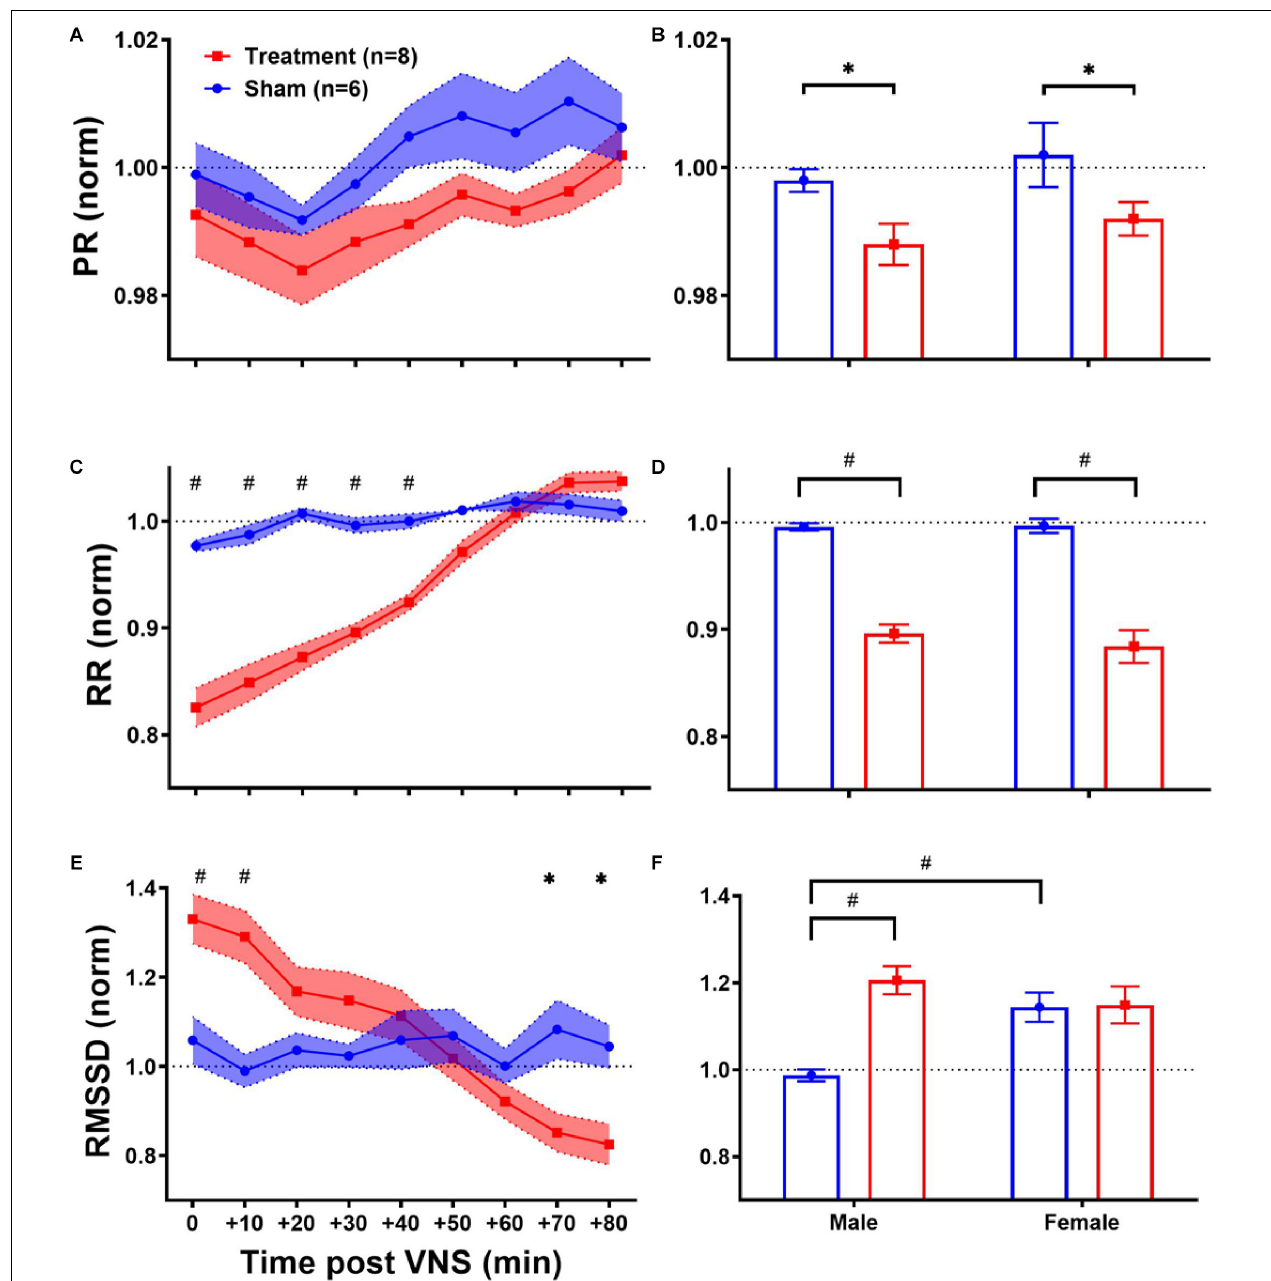
FIGURE 3 | Normalized short-term trends for ECG morphology and HRV time-domain features (mean ± SEM). (A,B) PR reduces in Sham and Treatment rats, and the effect was more pronounced in the Treatment group with longer recovery to the baseline level ( p > 0.05). The average effects for the first hour post-VNS (from 0 to + 50min) shows significant differences between Sham and Treatment groups for male and female rats ( p < 0.05) without any significant sex differences. (C,D) RR significantly reduces in the Treatment group with almost one-hour recovery time to the baseline level. The average effects for the first 1 h post-VNS (from 0 to +50 min) show significant differences between Sham and Treatment groups without any significant sex differences. (E,F) RMSSD significantly increases by ∼ 30% in the Treatment group with ∼ 20 min recovery. The average trend shows significant treatment effect only in male and significant sex difference in Sham groups. * p < 0.05 and # p <